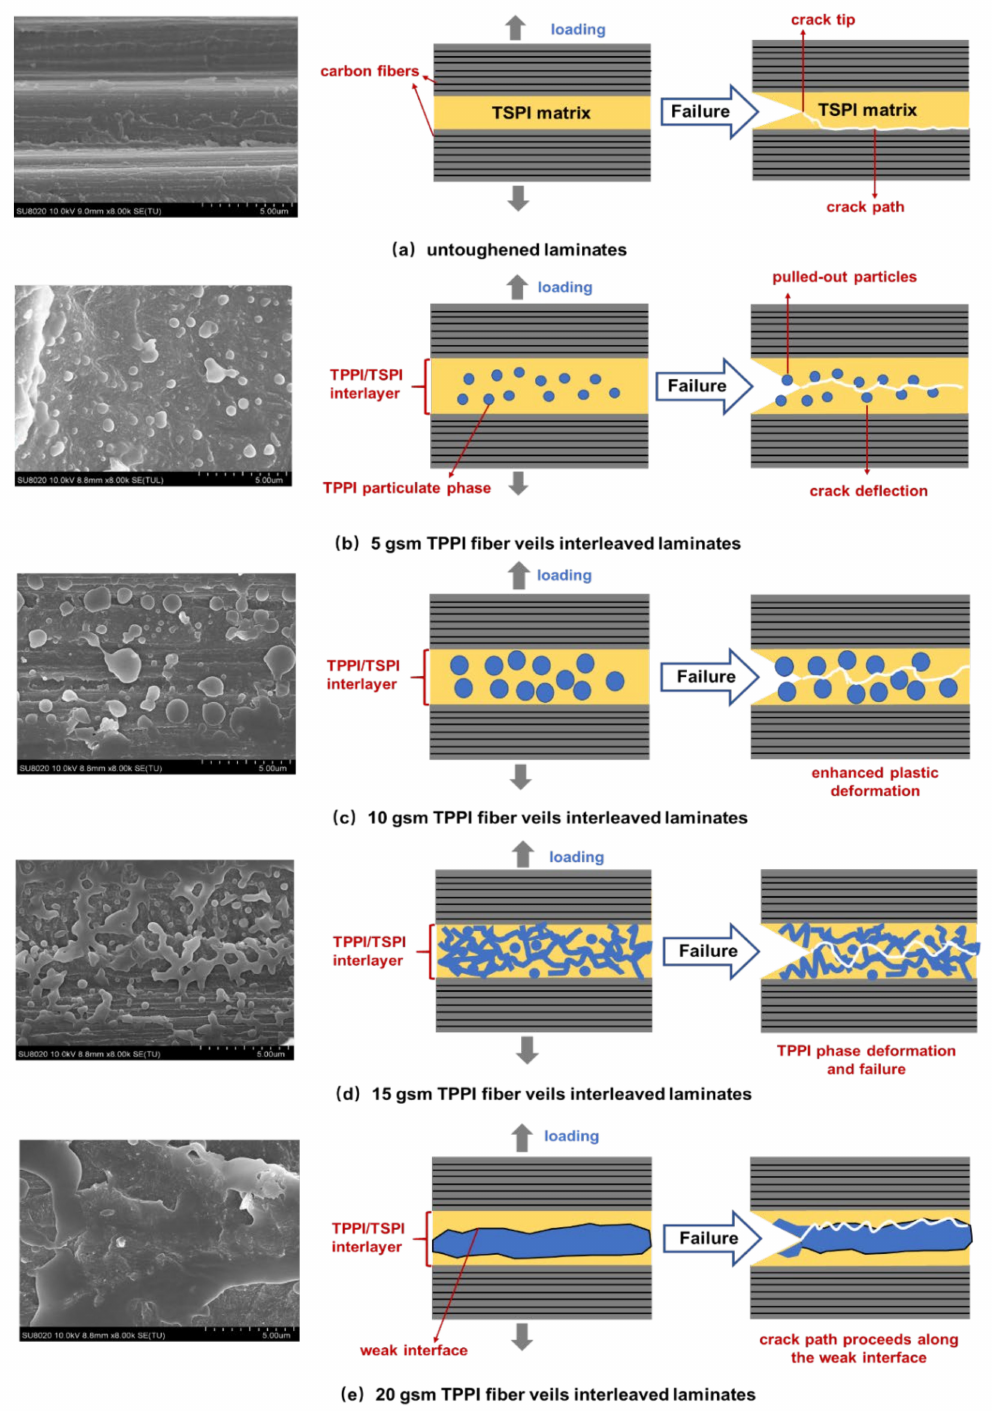
Figure 7. SEM micrographs of mode I fracture surfaces of untoughened and interleaved laminates and the schematic diagrams of the illustrated interlayer structure. ( a ) untoughened laminates; ( b ) 5 gsm TPPI fiber veils interleaved laminates; ( c ) 10 gsm TPPI fiber veils interleaved laminates; ( d ) 15 gsm TPPI fiber veils interleaved laminates; ( e ) 20 gsm TPPI fiber veils interleaved